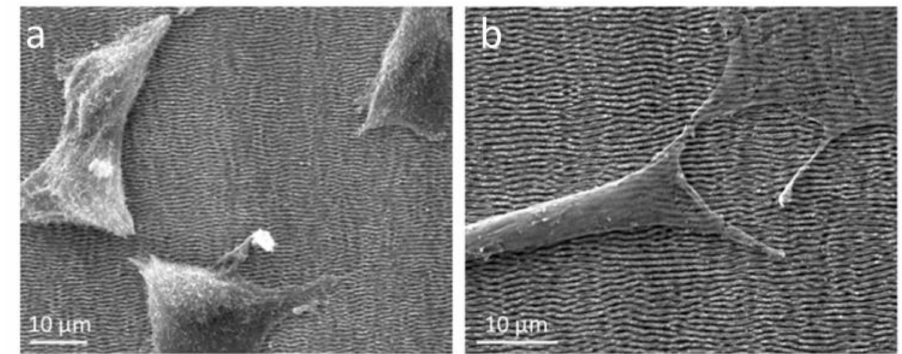
Figure 8. SEM images of NIH 3T3 fibroblasts cultivated on laser-modified 15 × (Ti / Zr) / Si multilayer after ( a ) two and ( b ) four days.